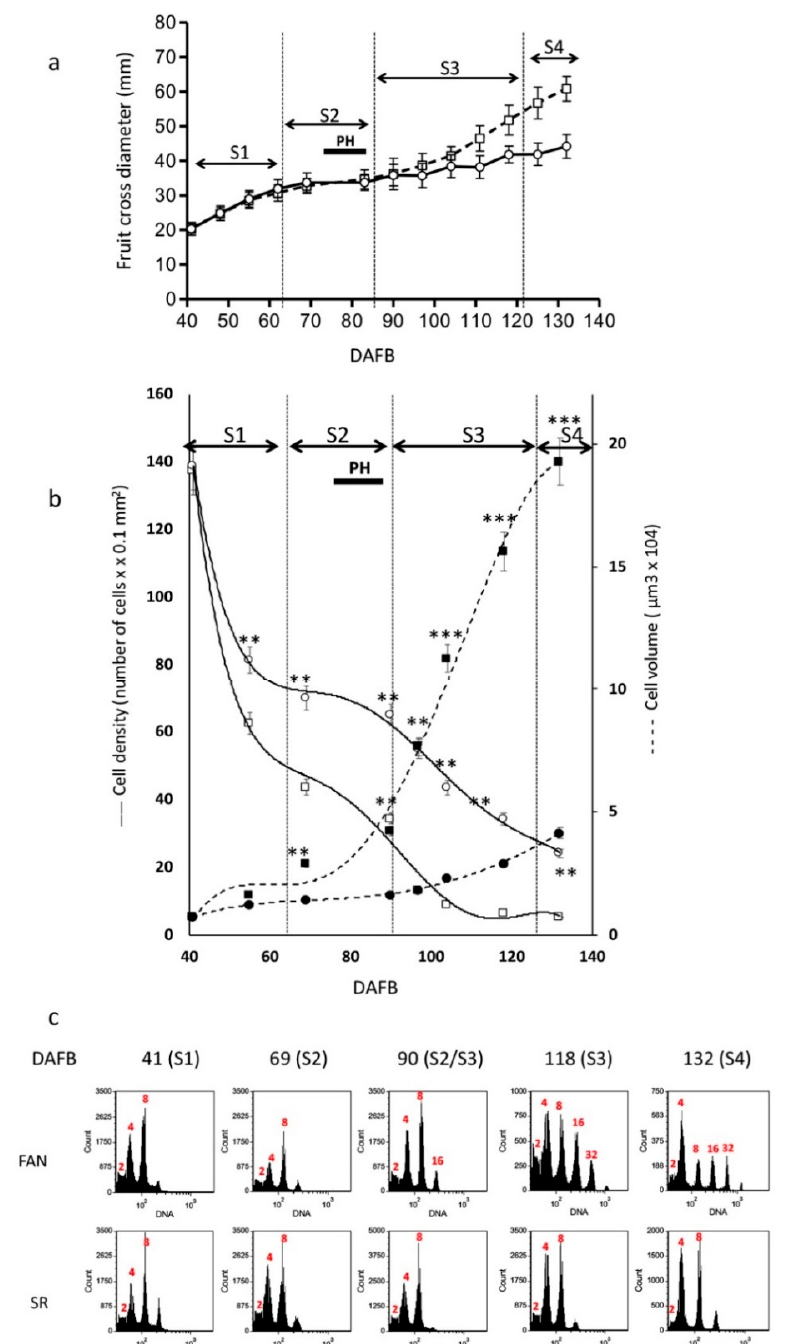
Figure 1. Fruit growth curve of cv FANTASIA (FAN) and slow ripening (SR) genotype. Cell density and volume, and cell cycle assessment by flow cytometry in mesocarp cells of FAN and SR were measured in samples collected in 2016, during the growth period from 41 to 132 days after full bloom (DAFB). ( a ) Diameter kinetic of FAN and SR fruits, represented by squares and dashed line and circles and continuous line, respectively. Bars represent standard deviation (n = 100). ( b ) Developmental changes in number of cells per 0.1 mm 2 and cell volume in FAN (square) and SR (circle) fruit. Standard errors are reported ( n = 5 fruits). Asterisks indicate statistically significant changes: ** = p ≤ 0.01, *** = p ≤ 0.0015. ( c ) Flow cytometry (FCM) analyses performed at different stages during FAN and SR fruit development. Red number indicates DNA content/ploidy (2C, 4C, 8C, 16 C, and 32C). Developmental stages (S1, S2, S3, and S4) are indicated at the top of each chart, taking FAN as a reference. DAFB, days after full bloom. PH, pit